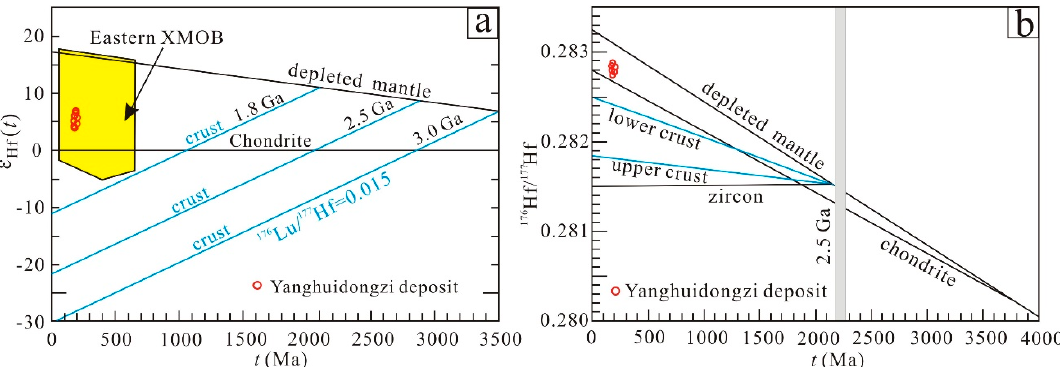
Figure 8. ( a ) Diagram of ε Hf ( t ) vs. U-Pb ages and ( b ) the 176 Hf/ 177 Hf vs. U-Pb ages of the Yanghuidongzi porphyry zircons (Hf isotopic composition of the Phanerozoic igneous rocks in the Eastern XMOB is from Yang et al. [59]).